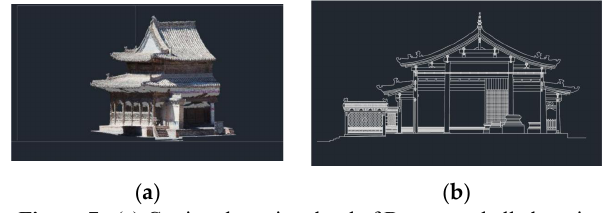
Figure 7 . (a) Cutting the point cloud of Baoguang hall along its structural frame; (b) extracting the cross-section of Baoguang hall through point cloud mapping.